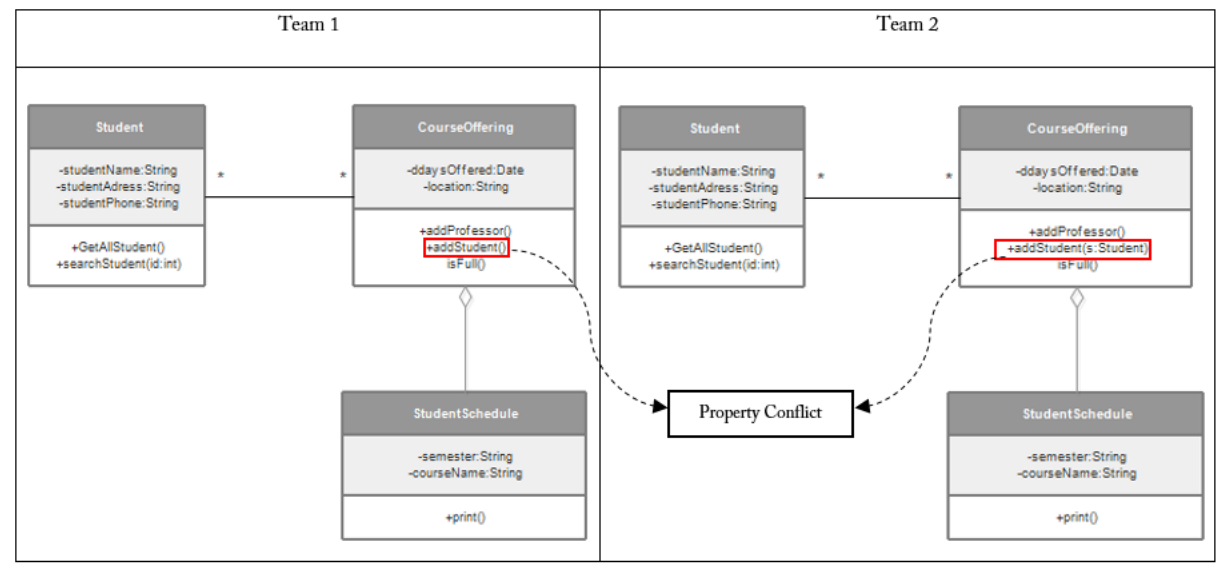
Fig. 5. An example of property conflict during the composition process of two class